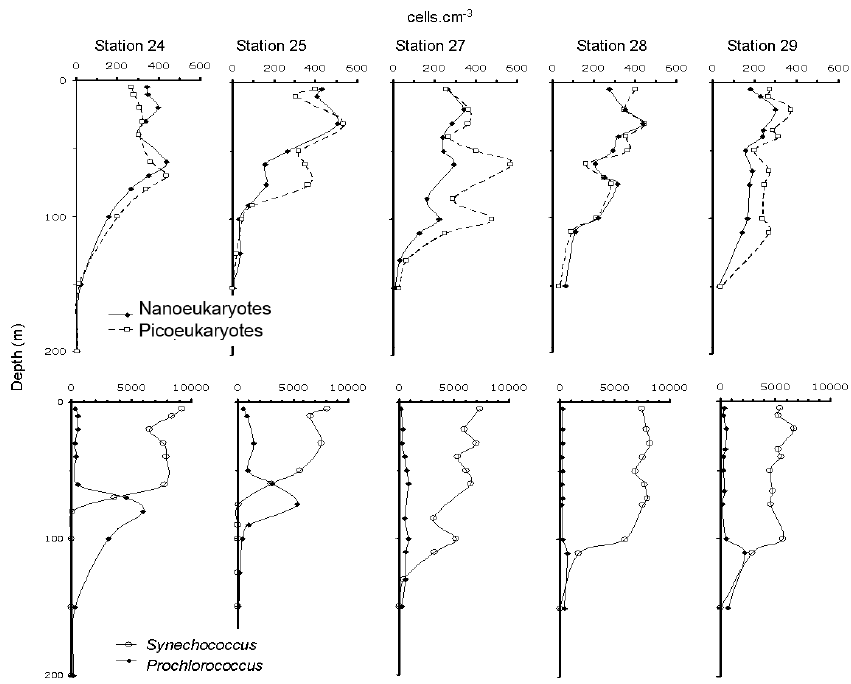
Fig. 8: Vertical profiles of ultraphytoplankton at stations 24 to 29 located along the transect crossing the thermohaline front at the eastern Ionian basin, as evidenced in Figure 6.